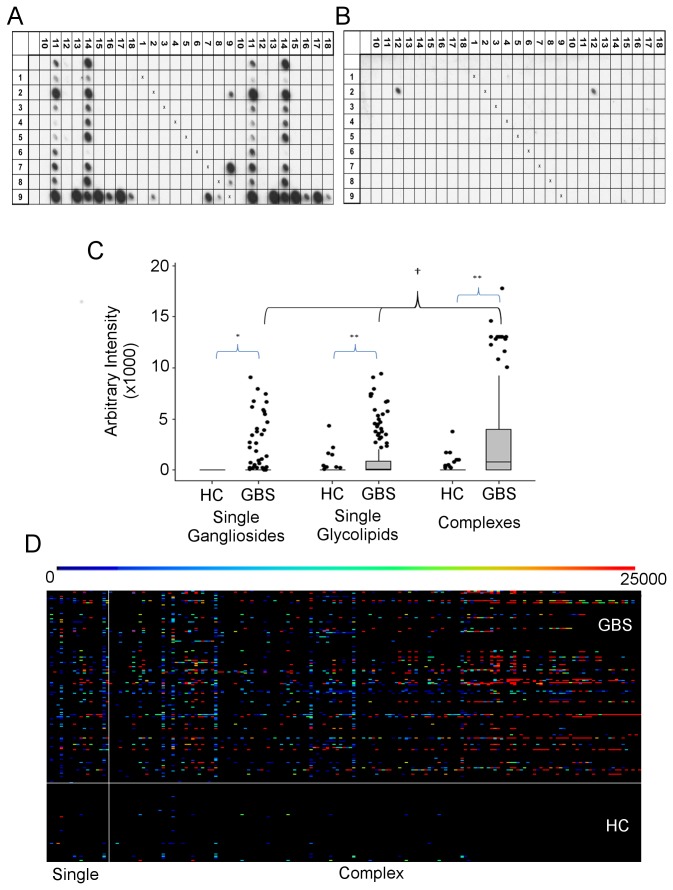
Diverse patterns of glycolipid binding in GBS sera.(A,B) Representative 28x10 arrays. The antigen spotted at each grid location is revealed by combining the row and column headings given in the key below. Thus, locations (9,7) and (7,9) contain GA1:GM3 complexes. The line of ‘x’ across the centre of the membrane represents the negative control spots (methanol only spotted). The left most column and upper most row contain single antigens only.(A) An array probed with GBS serum showing both complex attenuated and enhanced binding patterns. GD1b binding (14) is completely attenuated in complex with GD2 (location 14,6). In contrast, despite no demonstrable binding to GA1, GM3 or GD1a in isolation, an intense spot is seen with both GA1:GM3 (location 9,7) and GA1:GD1a (location 9,13) complexes. This is complex enhanced/complex dependent binding. (B) Highly specific complex-dependent GBS sera. In this example, only the duplicate spots of GM1:phosphatidylserine complex (location 2,12) are bound. (C) Boxplot of the distribution of maximum binding intensity for GBS versus healthy control (HC) sera assessed for single gangliosides, single glycolipids, and glycolipid complexes. Maximum binding intensity is significantly higher for GBS sera versus healthy control (HC) sera for each antigen group (*p<0.05, **p<0.0001). GBS sera maximum binding intensity for complexes is significantly higher than for either single glycolipids or gangliosides (†=p<0.001), but HC sera maximum binding intensity is insignificantly different between the antigen groups (not marked). (all Kruskal-Wallis/Mann-Whitney).(D) Overview heatmap of raw, unclustered binding intensities for GBS (above horizontal white line) and HC (below horizontal white line) sera. Antigens to the right of the vertical white line are glycolipid complexes. The intensity of binding is given by the bar above the heatmap, ranging from black (negative) to red (most intense). A more detailed, zoomable version of this heatmap, allowing resolution of results for each antigen and each serum, is available online (Figure S1). Key: (1)Sphingomyelin, (2)Phosphatidylserine, (3)Globoside, (4)Cereamide trihexosides (CTH), (5) Sulfated glucuronyl paragloboside (SGPG), (6)GM2, (7)GM3, (8)GD2, (9)Asialo-GM1, (10)Galactocerebroside (GalC), (11)LM1, (12)GM1, (13)GD1a, (14)GD1b, (15)GD3, (16)GQ1b, (17)GT1b, (18)Sulfatide.